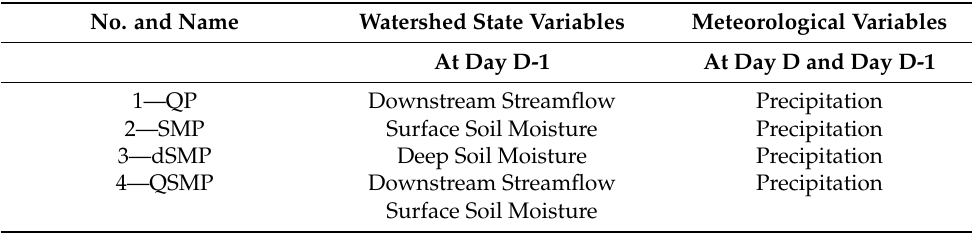
Table 3. Combinations of variables defined as artificial neural network (ANN)